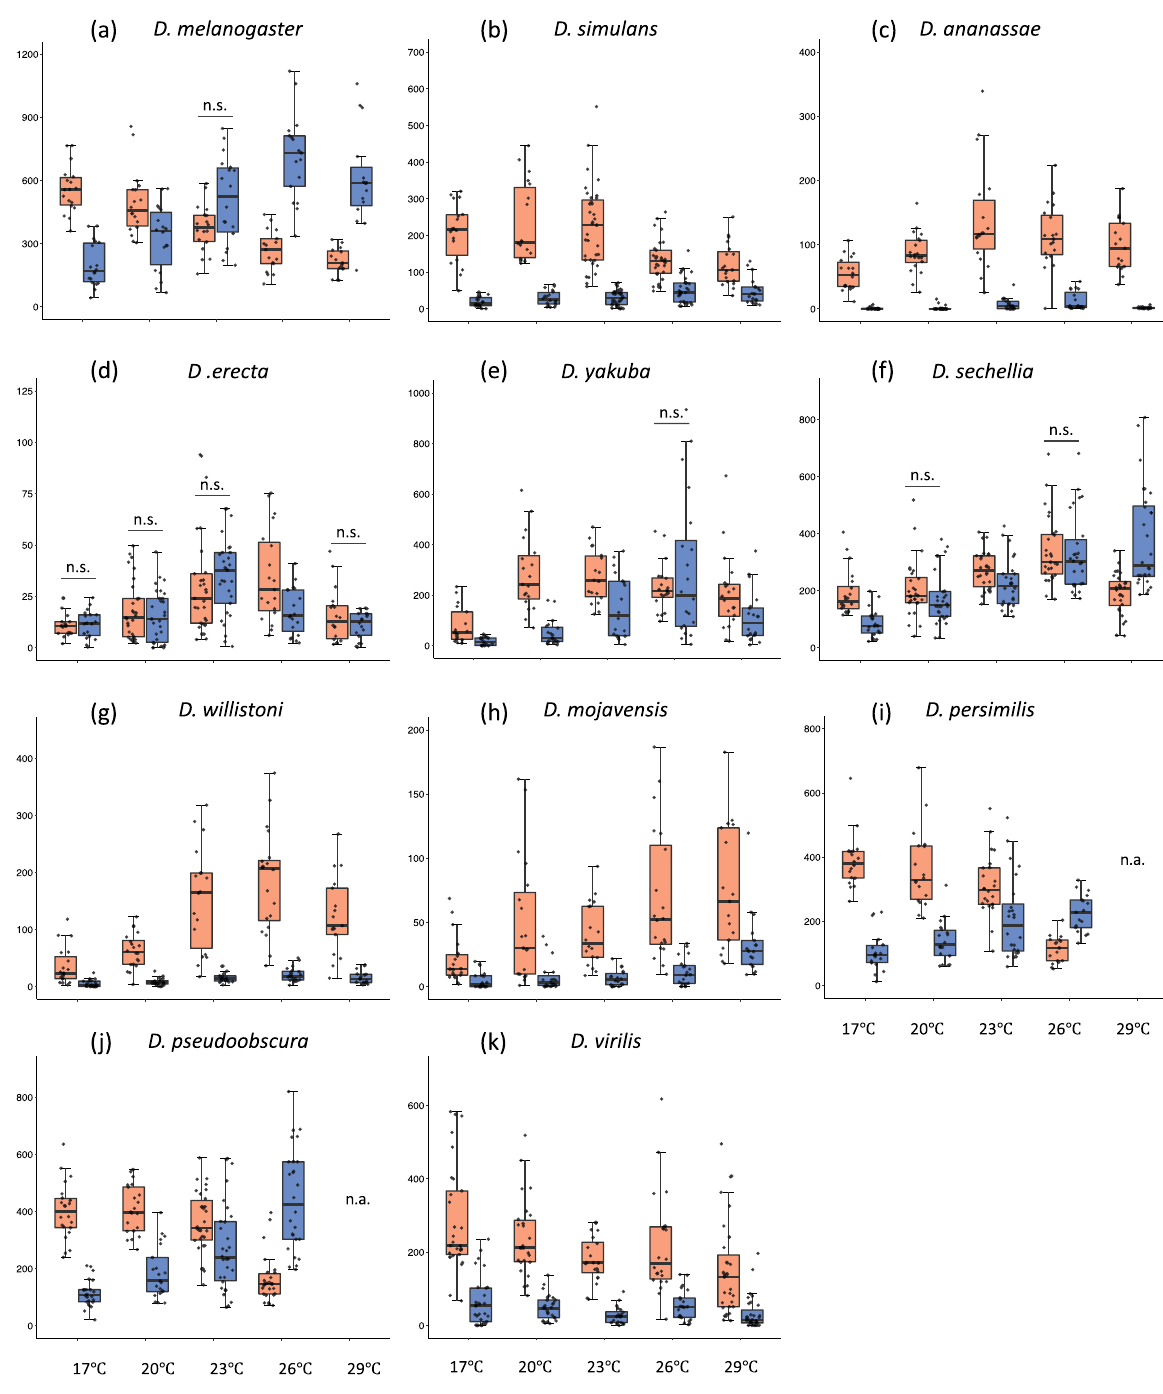
Figure 3. Daytime and nighttime locomotor activity of 11 Drosophila species at five different temperatures. ( a–k ) The daytime and nighttime locomotor activity in each species; ( a ) D. melanogaster , ( b ) D. simulans , ( c ) D. ananassae , ( d ) D. erecta , ( e ) D. yakuba , ( f ) D. sechellia , ( g ) D. willistoni , ( h ) D. mojavensis , ( i ) D. persimilis , ( j ) D. pseudoobscura , and ( k ) D. virilis . The y axis shows the activity levels (counts). Caution that the y axis range are different among species. Box plots are shown as Fig. 1. Orange box indicates daytime and blue box indicates nighttime locomotor activities. The horizonal bars with n.s. above the box daytime and nighttime pairs indicates not significant differences (Mann–Whitney U tests, p > 0.05), otherwise each pairs shows a significant difference (Mann–Whitney U tests, p < 0.05). In all species, the amount of daytime and nighttime activities is significantly affected by temperatures (Kruskal–Wallis tests, p <